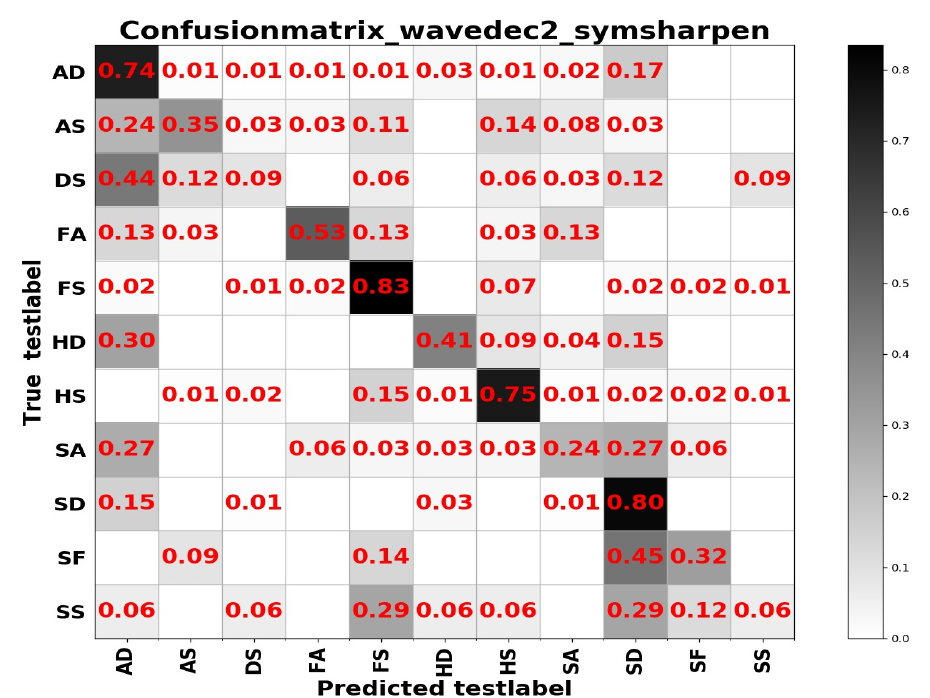
Figure 12. The confusion matrix of the RAF Compound test based on the input channels composed of the combination of spatial and frequency domain images under wavelet base